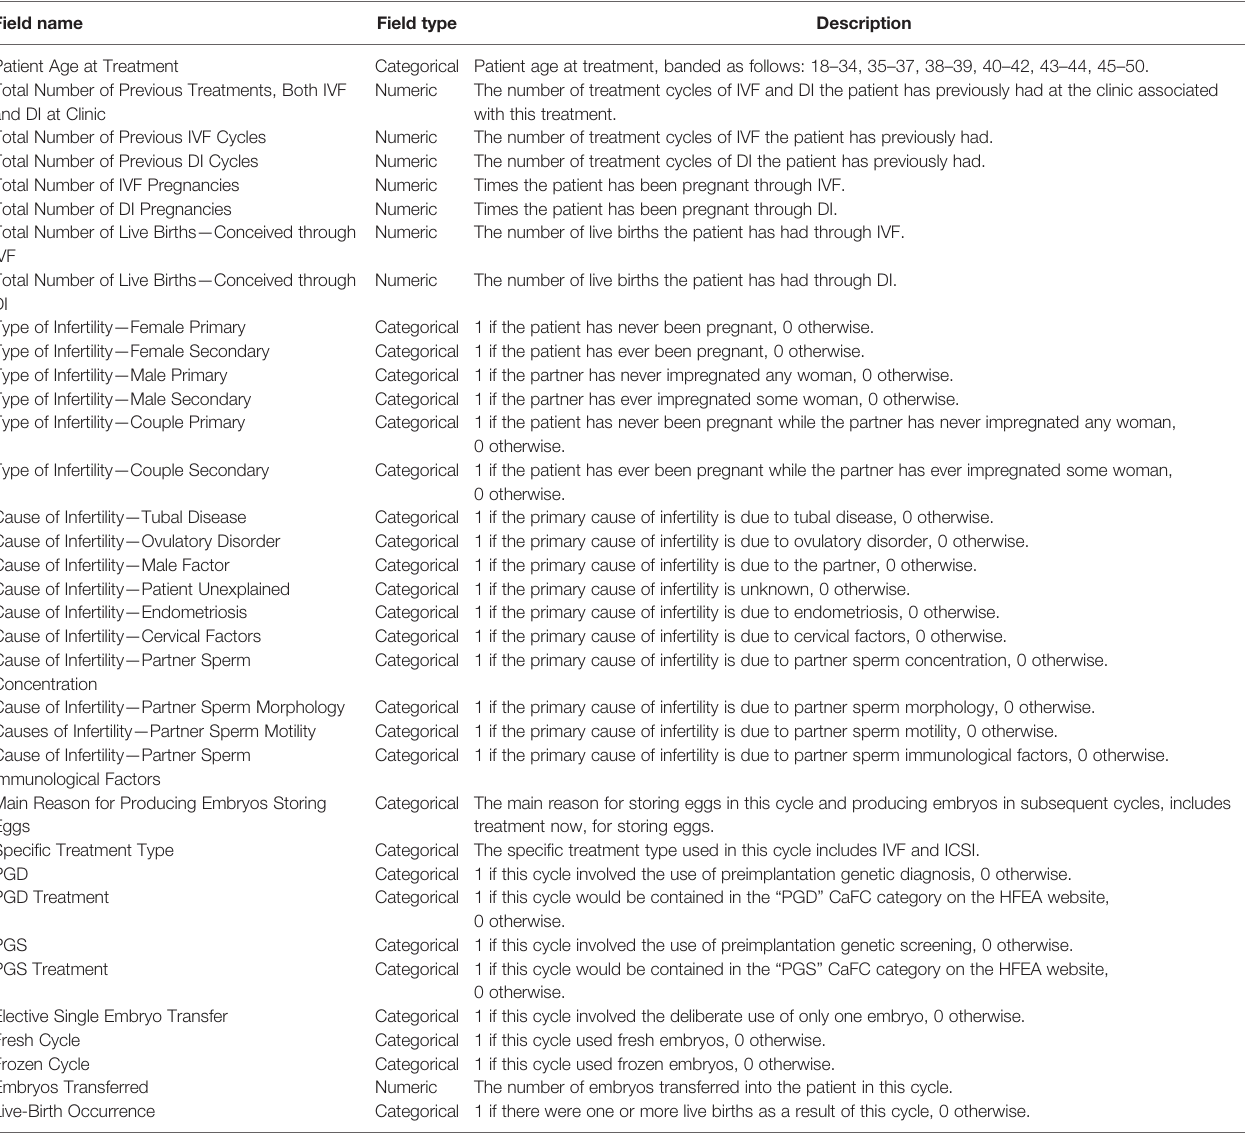
TABLE 1 | Description of 35 fi elds in the